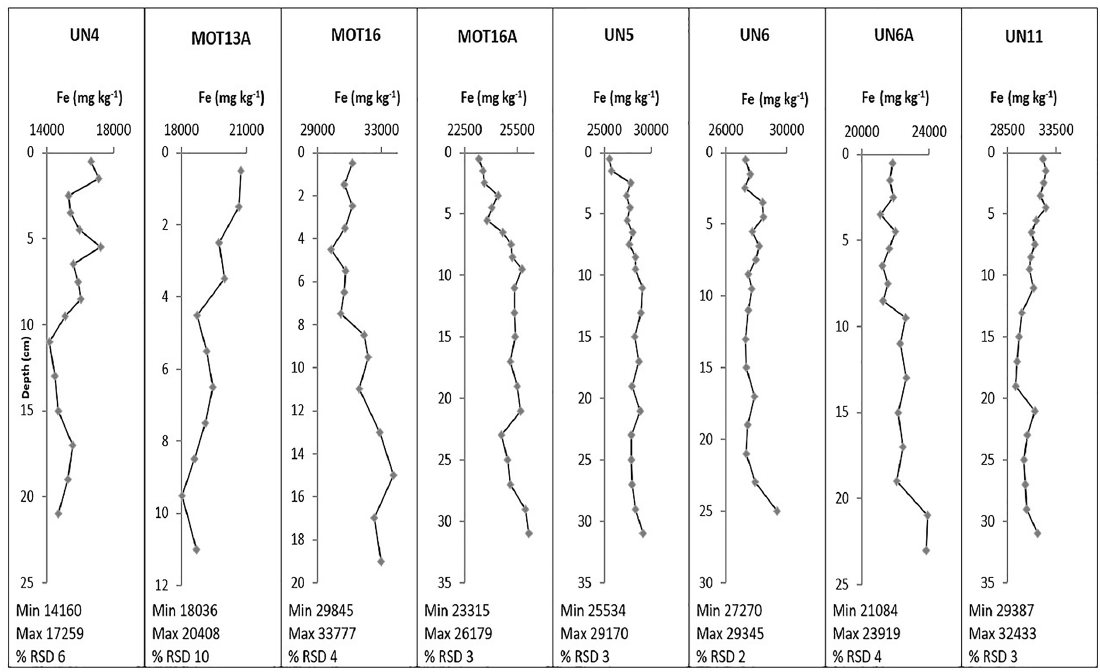
Figure A6. Vertical distributions of Fe (in mgkg − 1 ) in sediment cores. The concentrations in the coarse cores MOT13A, MOT16 and UN4 refer to the total sediment fraction ( f <